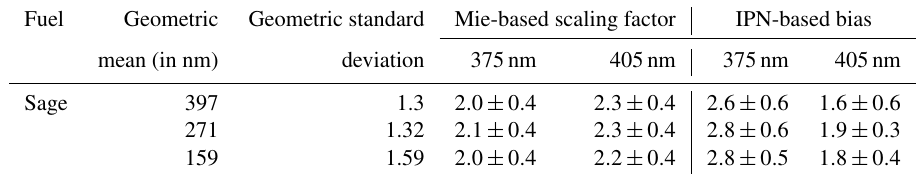
Table 5. Correction factors for bulk solution absorption to particle-phase absorption, based on Mie theory